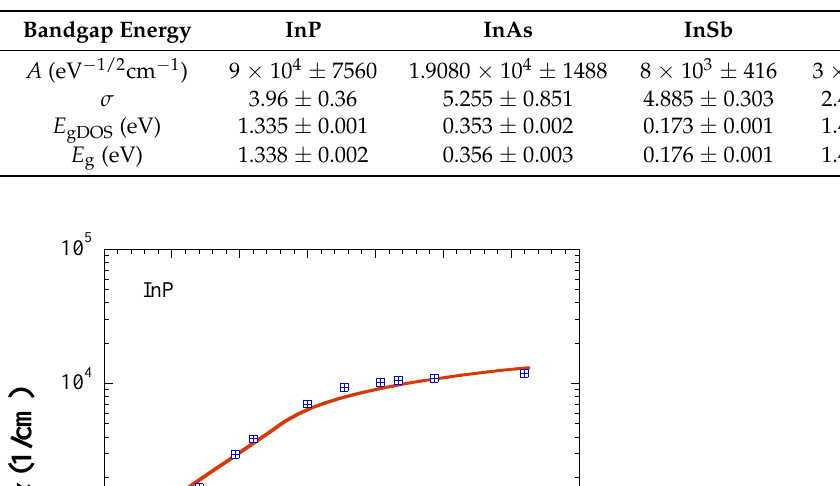
Table 1. Fit parameter for the fits in Figures 1–4.